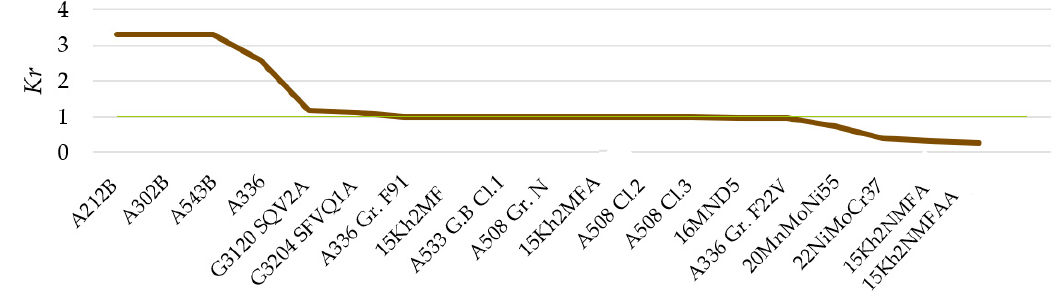
Figure 4. K r for the materials analyzed.